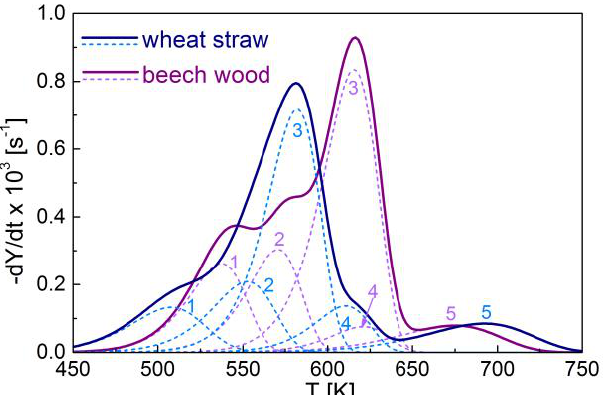
Figure 3. Predicted mass-loss rate for wheat straw (data in Table 2A,B), − dY/dt, and predicted rates of volatile release (dashed lines) from components n. 1 – 5 versus temperature (heating rate 5 K/min, up to 773 K).